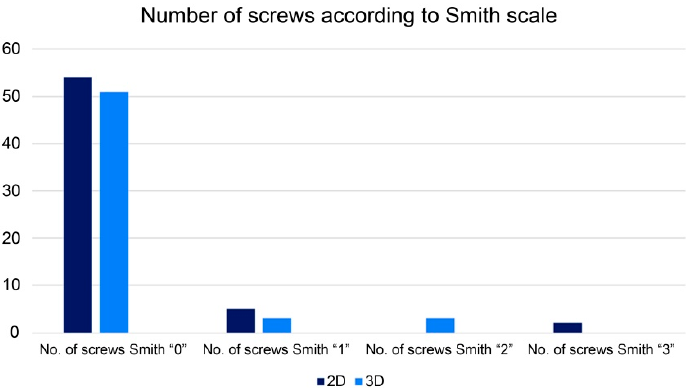
Figure 5. Number of screws in Group N1 (2D) and N2 (3D) according to the Smith scale.